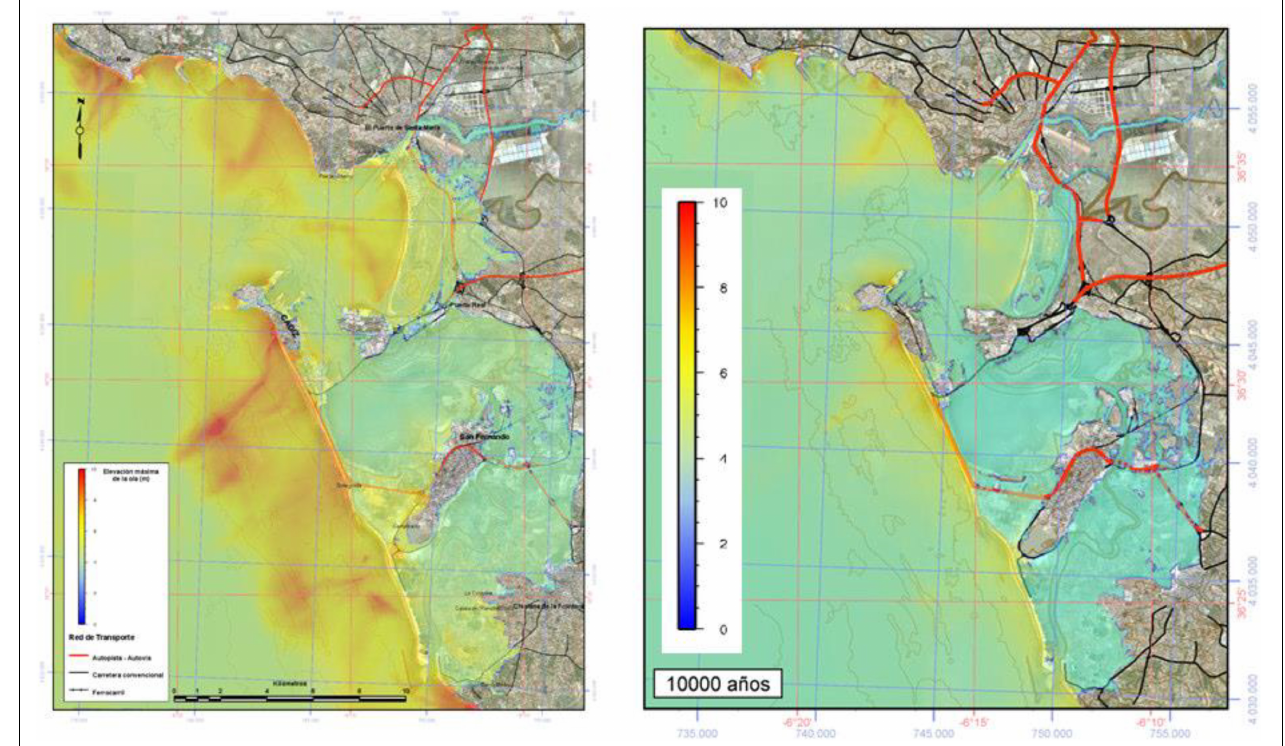
FIGURE 14 | Comparison of the aggregated maximum wave elevation obtained for the high tide condition in the deterministic and in the probabilistic approaches (Tr = 10000 years and a confidence interval of 99%).